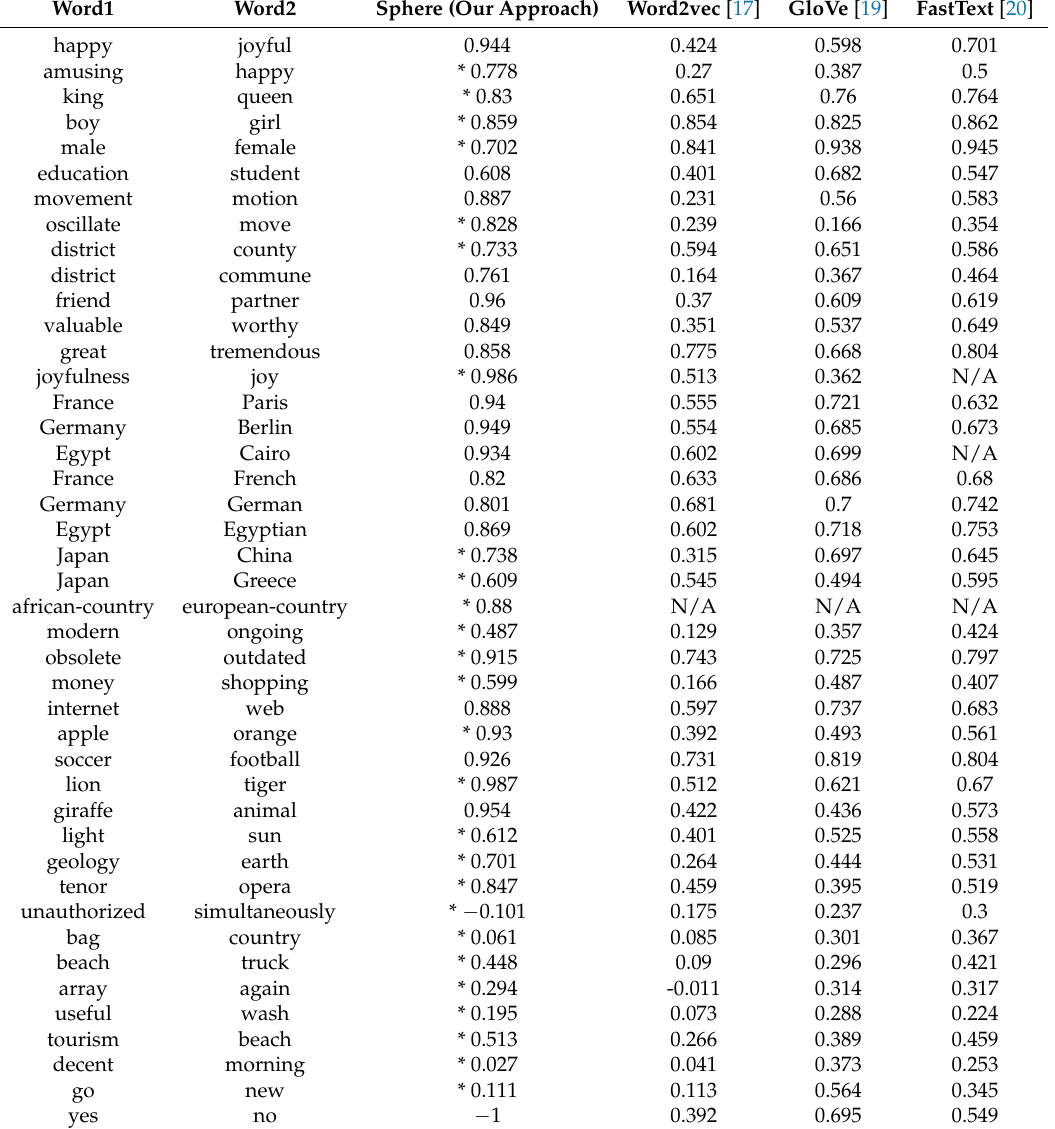
Table 2. Word similarity comparison (* means the pair is not part of the training set for our